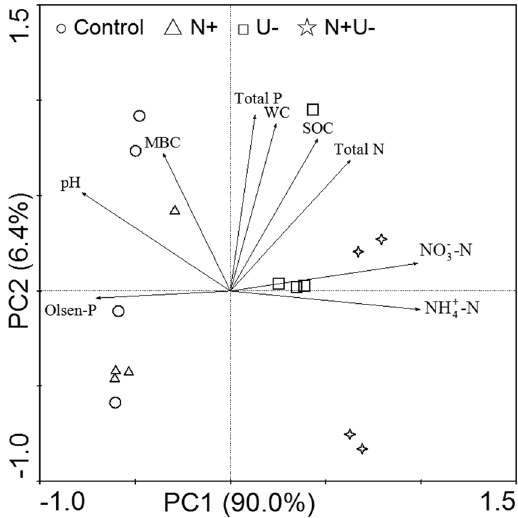
Figure 1. Ordination diagram with variables and samples from principal component analysis (PCA) of soil variables in a Mongolian pine plantation. Each symbol represents a sample. Lines with arrow represent soil variables, and arrow points in the direction of steepest increase of values. The smaller angle between two variable arrows indicates stronger correlation, as the cosine of the angle between variable arrows equals their correlation coefficients. N + : N addition; U − : Understory